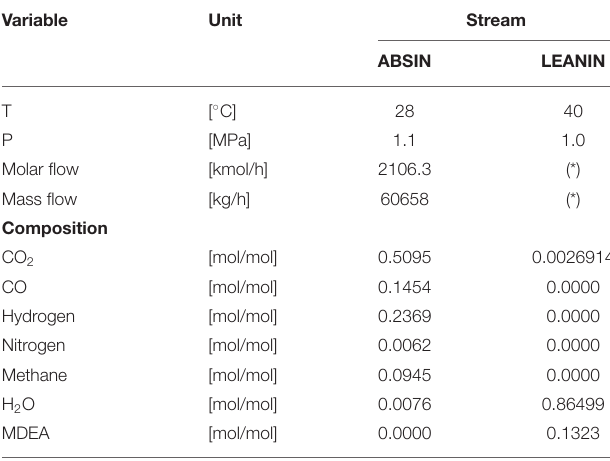
TABLE 2 | Data on the PSA tail gas stream entering the absorber after compression ( ABSIN in Figure 1 ) and on the lean amine solvent stream ( LEANIN in Figure 1 ) (the composition of the lean solvent corresponds to an MDEA weight fraction of 0.5 and to a CO 2 lean loading of 0.0203mol CO 2 /mol MDEA).